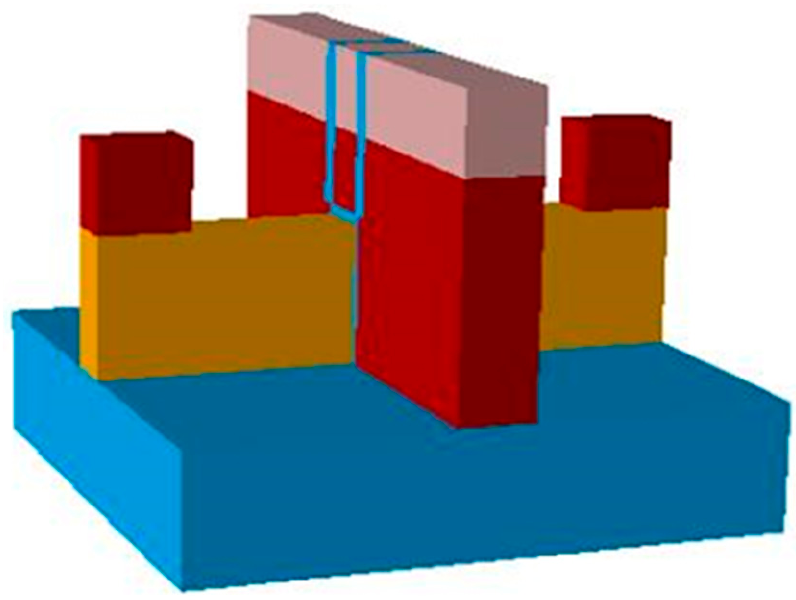
Figure 2. Device structure diagram.